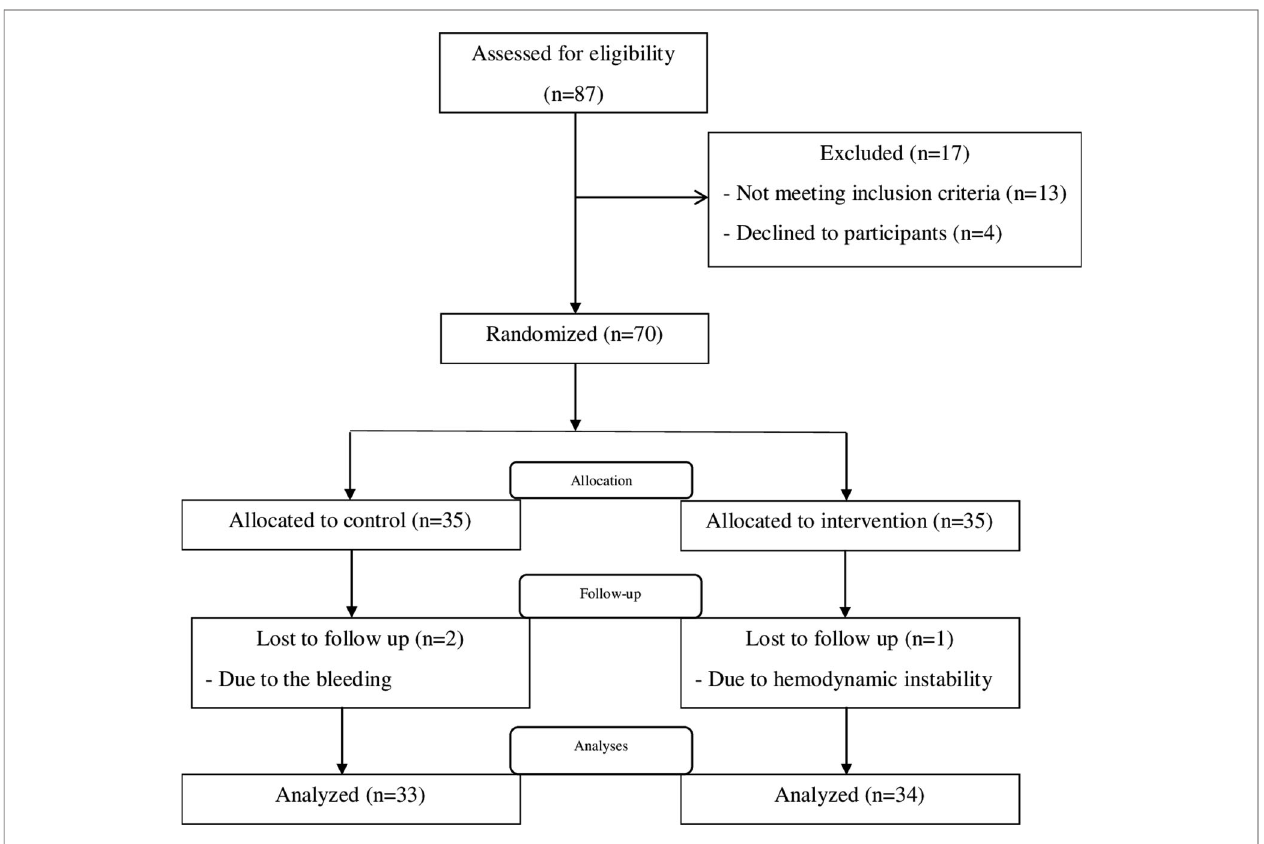
FIGURE 2 | The study fl ow